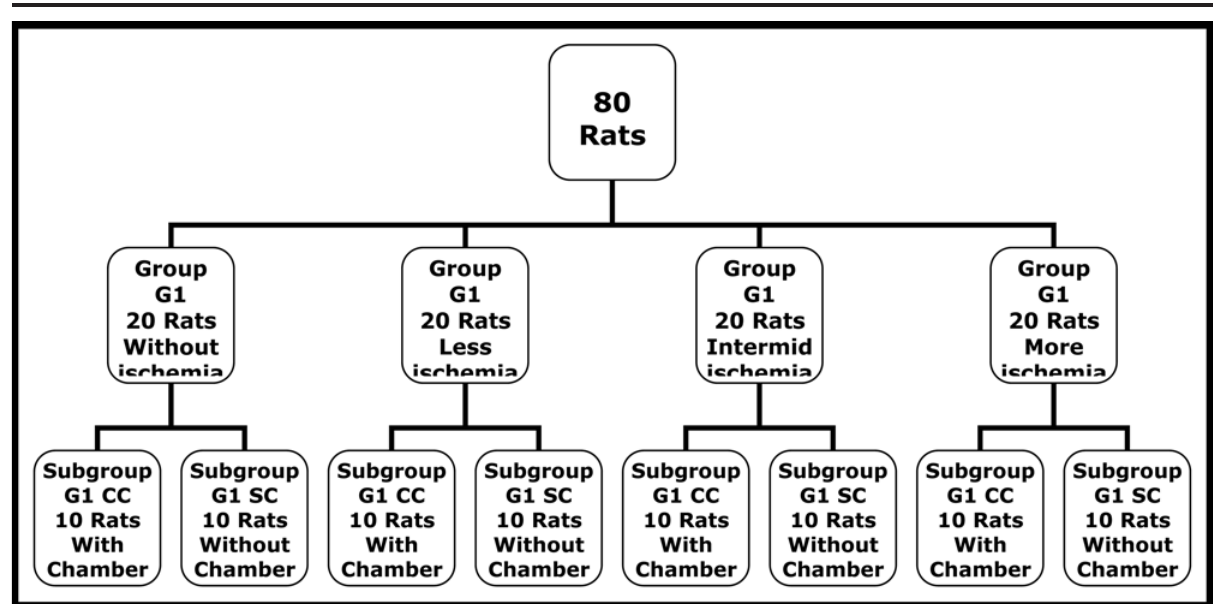
FIGURE 1 - Experimental fluxogram. Groups and subgroups distribution and